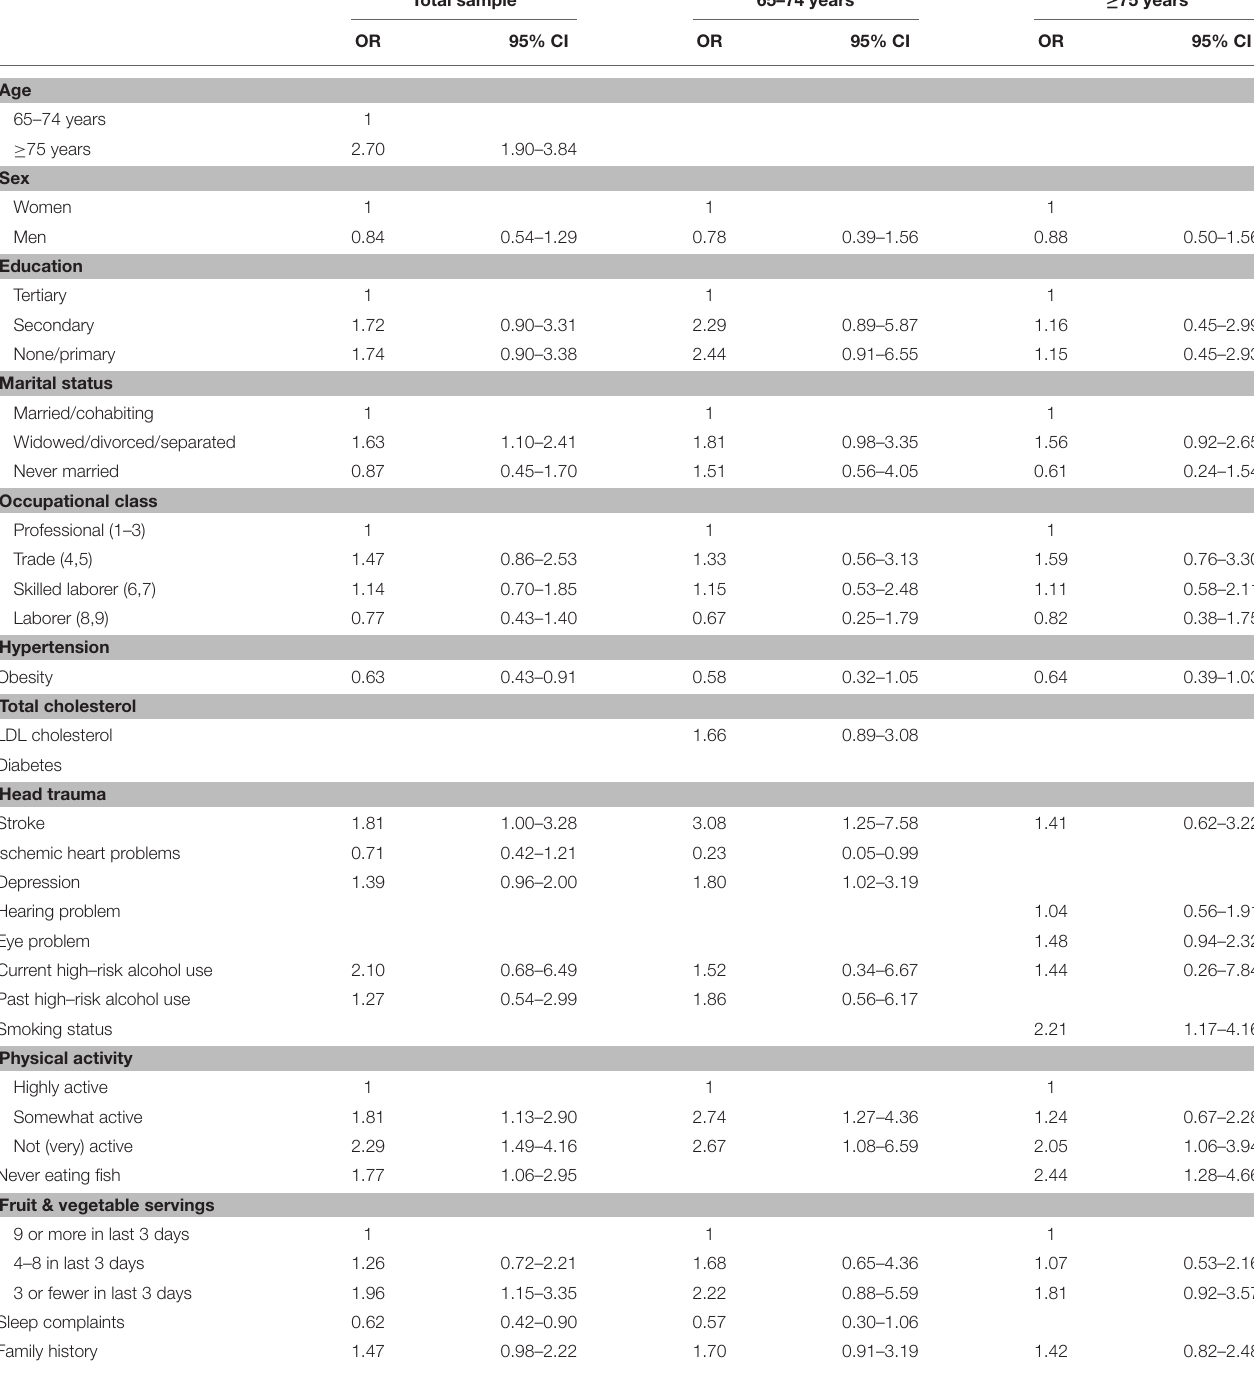
TABLE 3 | Multivariable models for the total sample ( n = 1,846), and stratified by